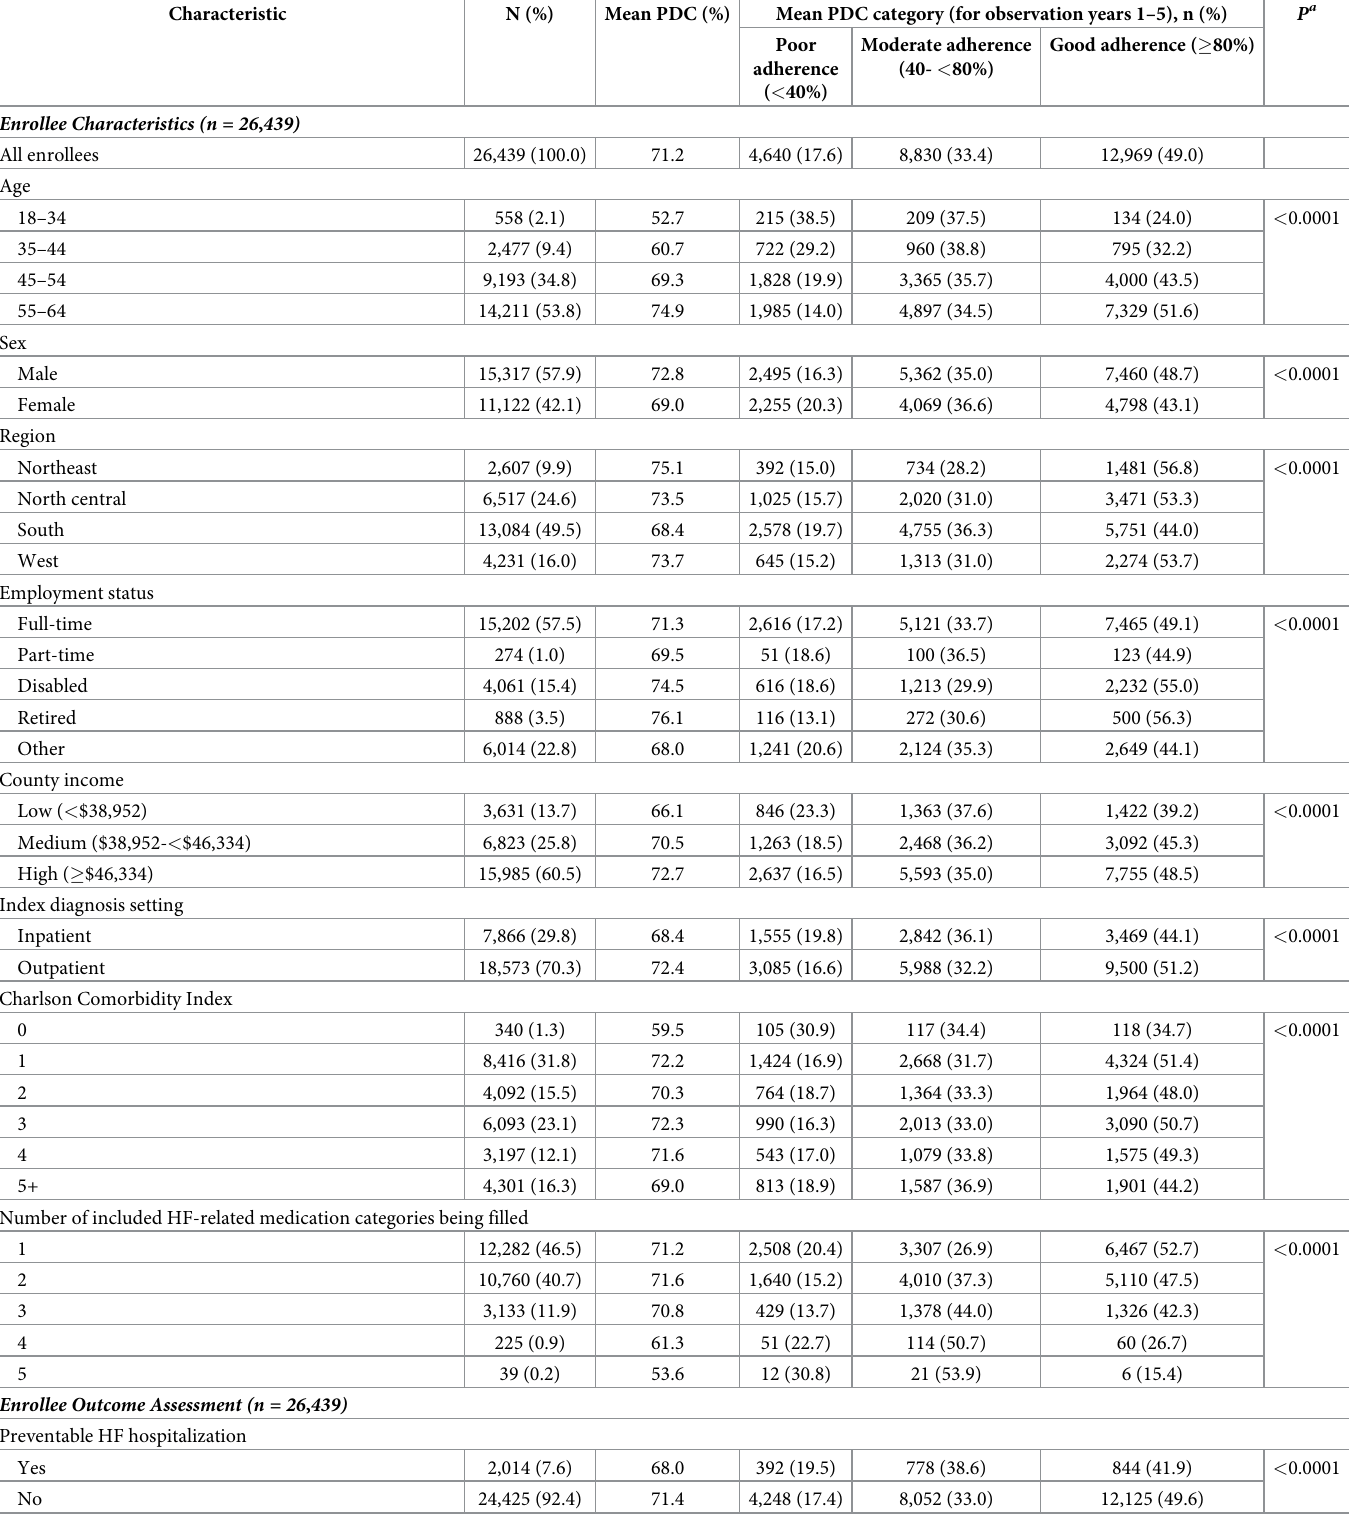
Table 1. Characteristics of all enrollees by long-term adherence, MarketScan 2008–2012 (N = 26,439).